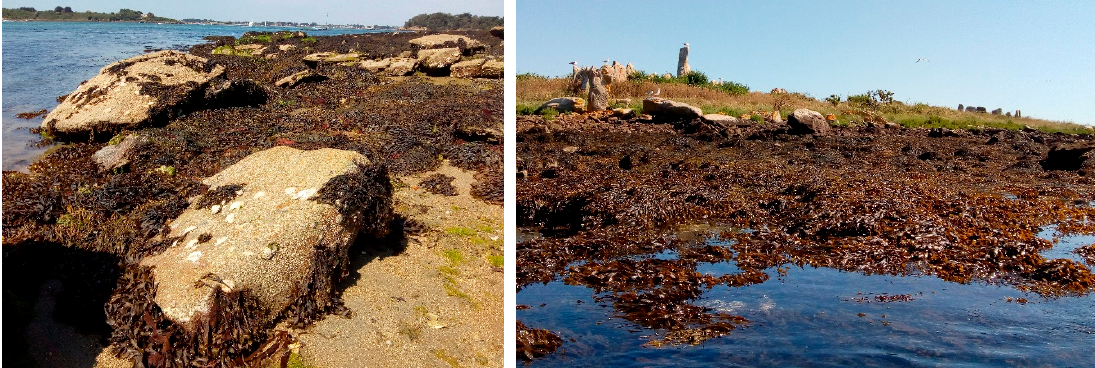
Figure 2 . Megalithic monument of Er Lannic . Figure 2. Megalithic monument of Er